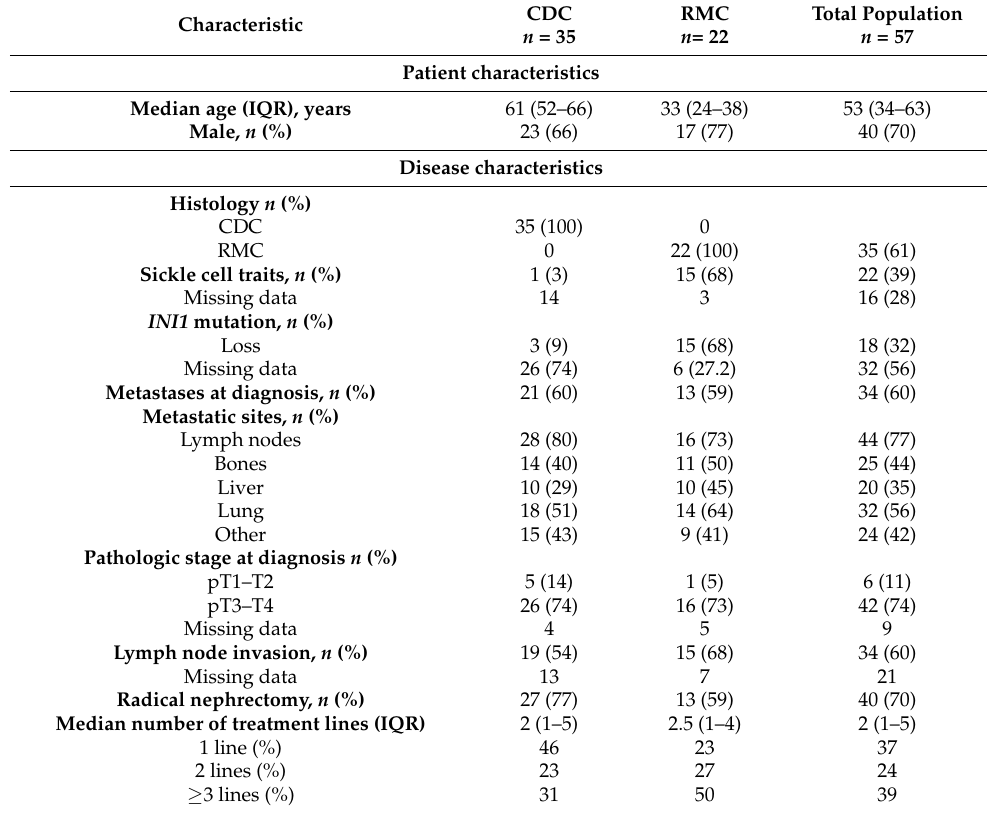
Table 1. Patient demographics and clinical